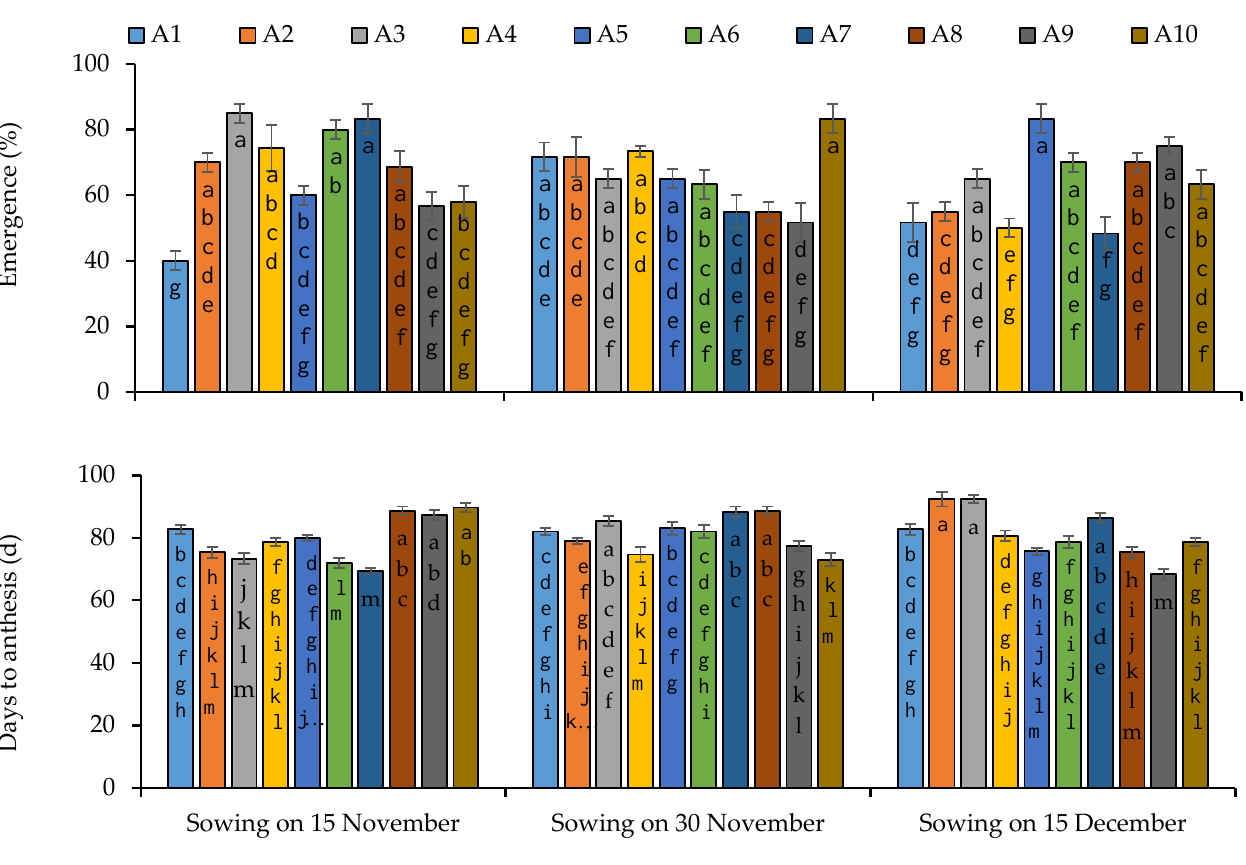
Figure 1. Emergence percentage and days to anthesis of quinoa lines grown under varying sowing dates. Bars sharing the same alphabet did not differ significantly at p < 0.05. Small alphabets (a, b, c. etc.) are used to express the statistically significant